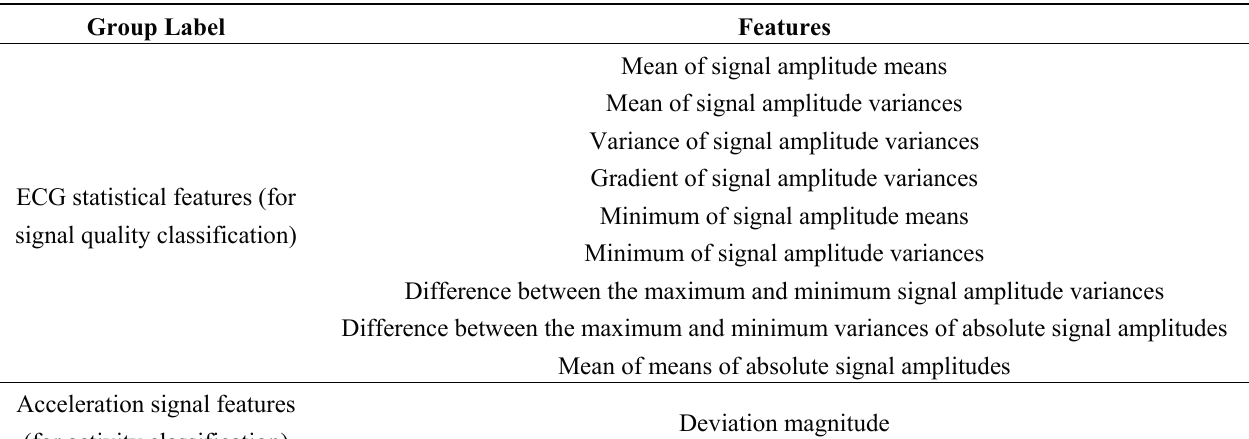
Table 4. Segment-based features used for signal quality classification and activity